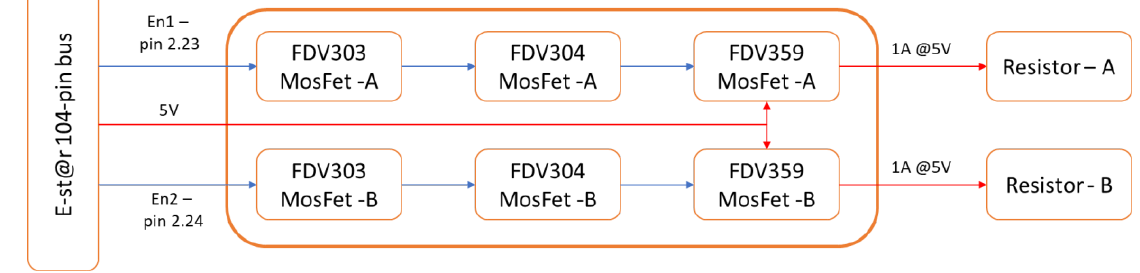
Figure 9. Deployment mechanism block diagram.